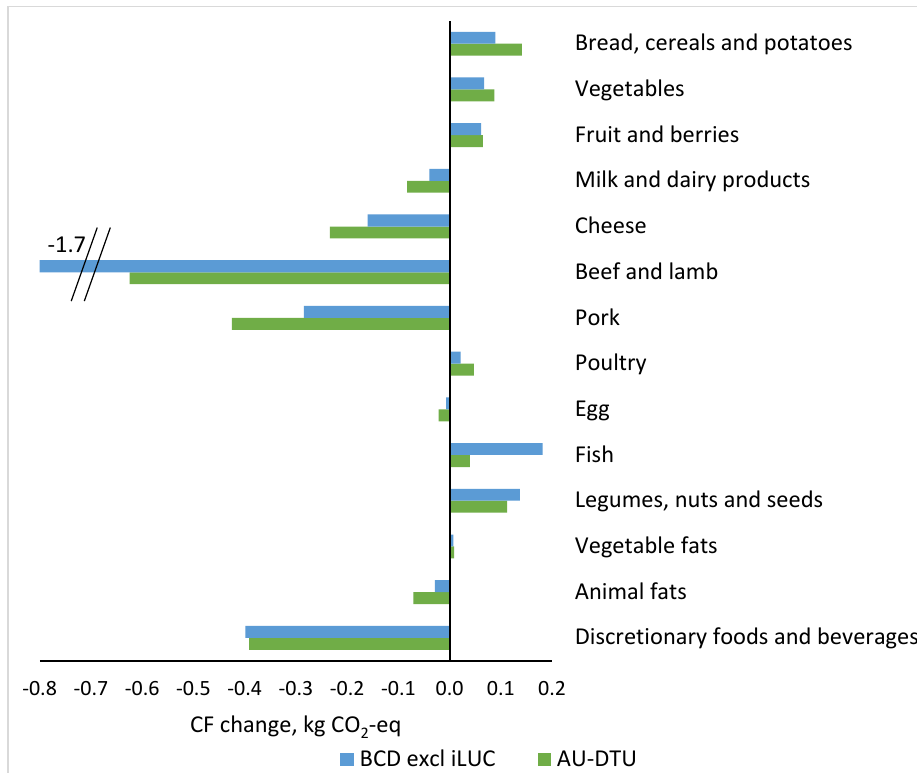
Figure 2. Contribution to the carbon footprint (CF) change in the transition from the current diet to the plant-rich diet from selected food groups and estimated based on two sets of CF data, kg CO 2 -eq per 10 MJ diets. System boundary is at the retail gate. The current food intake: The Danish National Survey on Dietary habits and physical Activity (DANSDA) 2011–2013, adults 18–64 years [24]. The food intake of the plant-rich diet: Lassen et al. 2020 [9]. The AU-DTU data are compiled by researchers from Aarhus University and DTU (Technical University of Denmark) described in methodological Section 2.3 of the present study. The Big Climate Database (BCD): published by the Danish green think tank CONCITO [23] described in [18]. iLUC: indirect land use change.